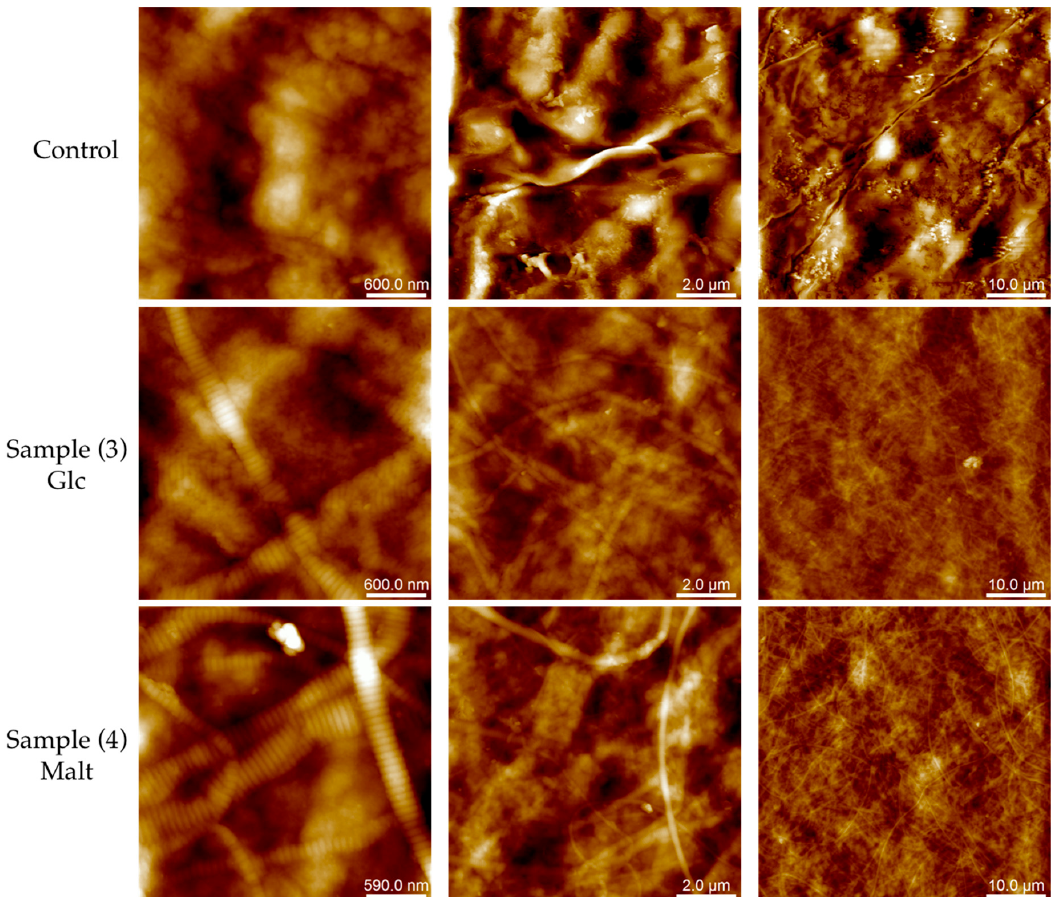
Figure 4. Representative atomic force microscopy (AFM) topography image of collagen films acquired in PeakForce mode in air. Different scan sized images of collagen matrix without further modification, glucose (line 2) and maltose (line 3) neoglycosylated collagen films were collected. From left to right : column 1 (3 × 3 µ m 2 , 512 × 512 pixel, Z-scale 200 nm), column 2 (10 × 10 µ m 2 , 512 × 512 pixel, Z-scale 500 nm), and column 3 (50 × 50 µ m 2 , 512 × 512 pixel, Z-scale 1.4 µ m). For 3D Lighting images and different Z-scale range see Figures S3 and S4